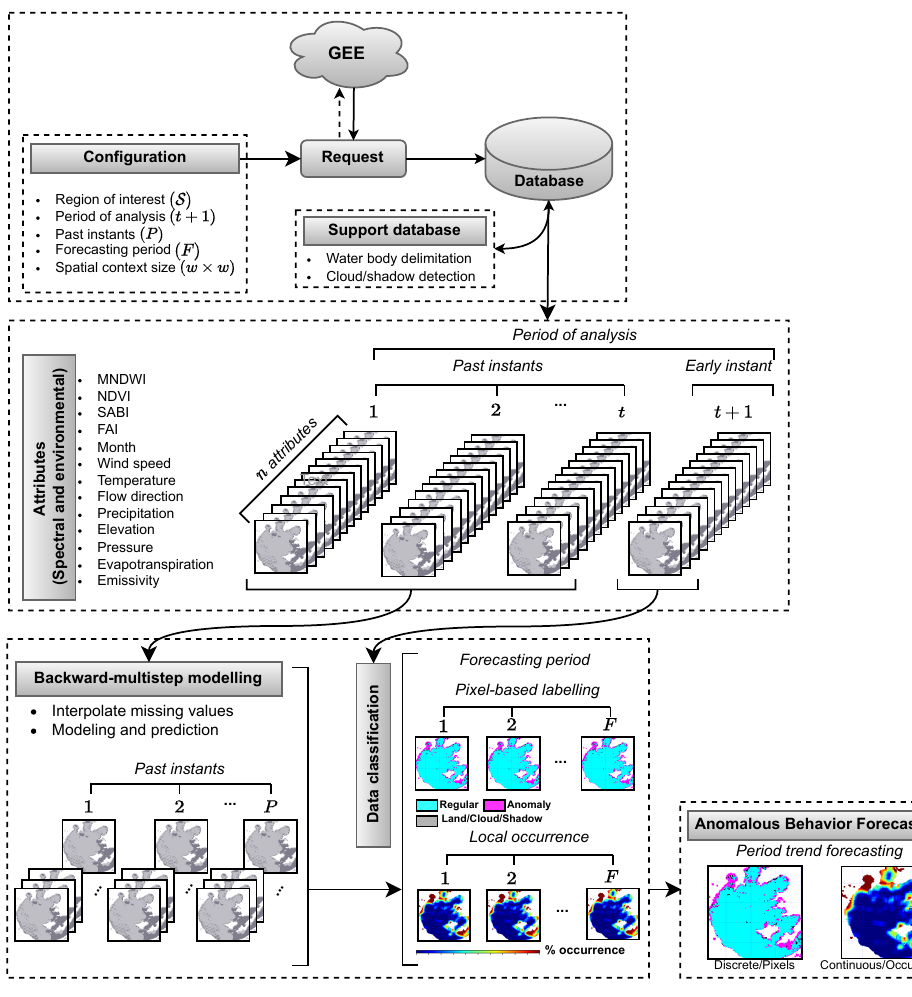
Figure 2. Overview of the proposed